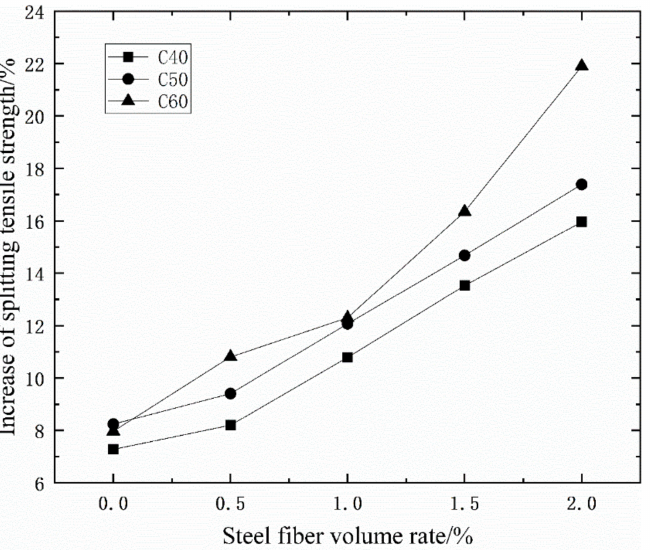
Figure 10. The improvement of the splitting tensile strength of vibrating mixing compared with ordinary